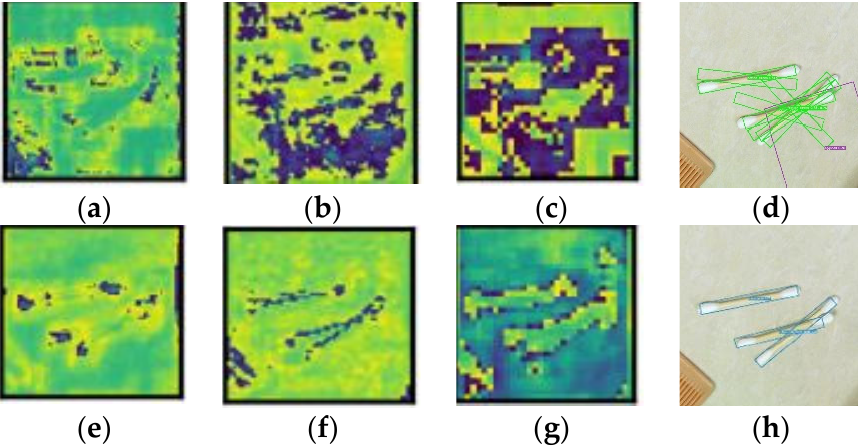
Figure 12. Feature aggregation network maps of YOLOv5 and YOLOv5m-DSM. ( a – d ) Multi-scale feature maps and detection result of YOLOv5m. ( e – h ) Multi-scale feature maps and detection result of YOLOv5m-DSM.